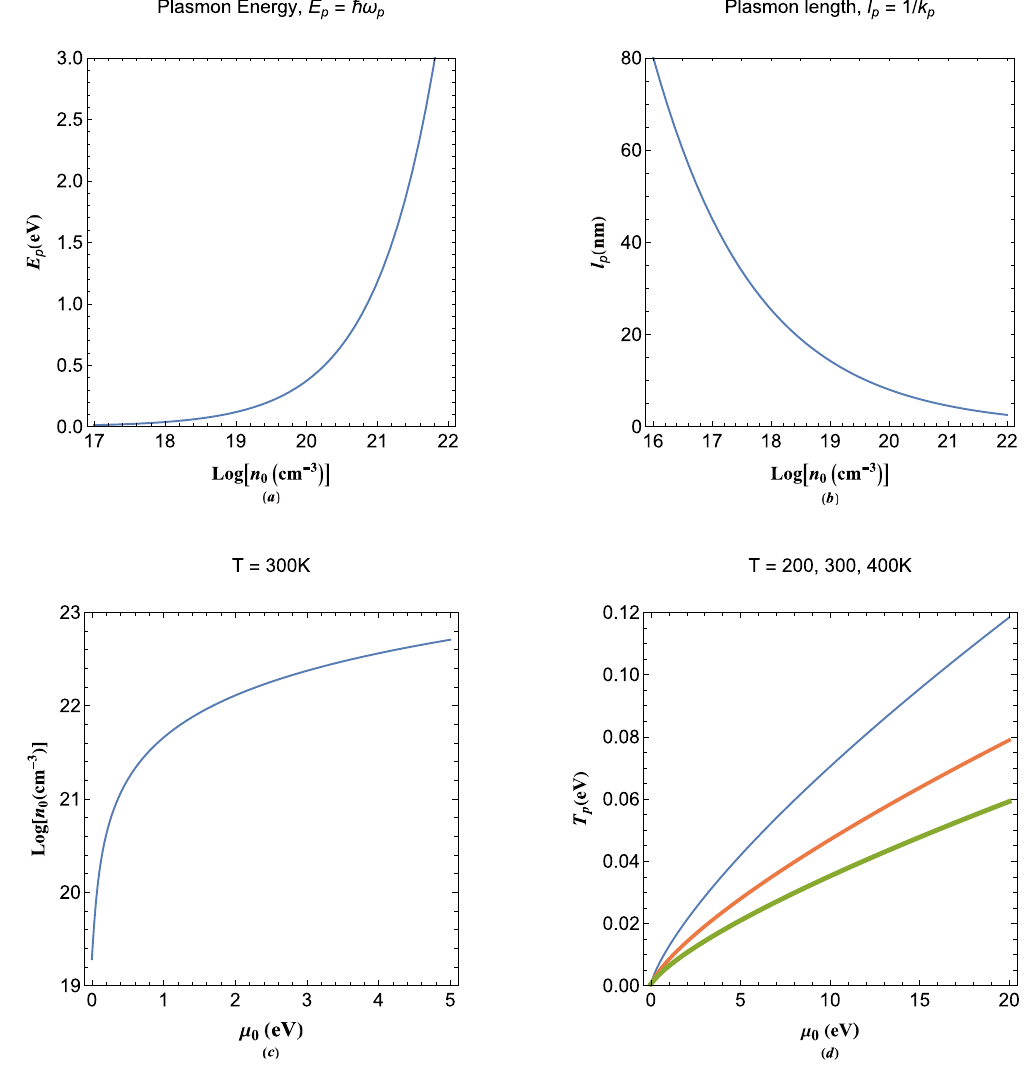
(cid:31) ω Figure 1. ( a ) Variation in the plasmon energy E p p in terms of electron number density in logarithmic = scale. ( b ) Variations in plasmon length 1 / k p with electron number density in logarithmic scale. ( c ) The electron concentration in terms of equilibrium chemical potential of arbitrary degenerate electron gas. ( d ) Variation of E p / k B in terms of the chemical potential of the electron gas for different values of the plasmon temperature T p = electron temperature. The increase in thickness of curves indicates the increase in varied parameter above the panel in Fig